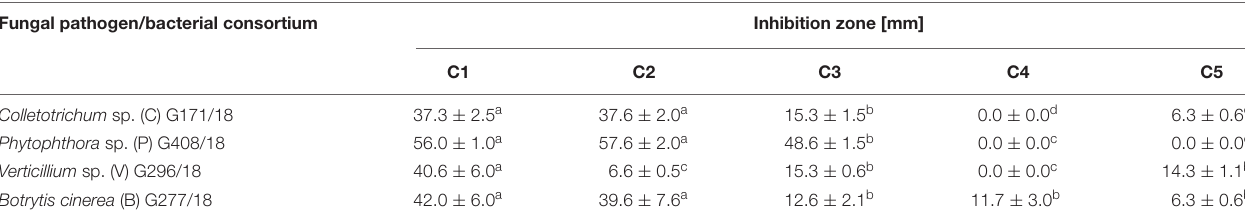
TABLE 2 | Antifungal properties of the bacterial consortia used in the test expressed as the inhibition zone diameter (mm). Fungal pathogen/bacterial